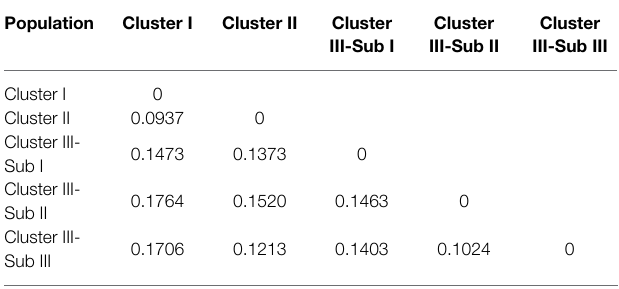
TABLE 5 | The matrix of pairwise genetic differentiation among populations (Fst) based on SSRs. Population Cluster I